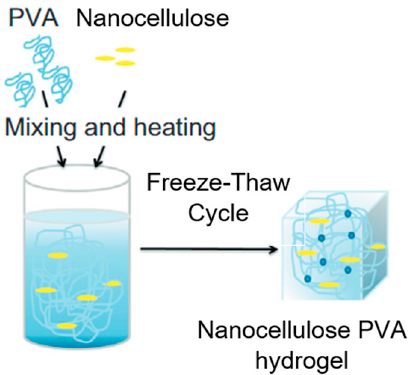
Figure 7. Simple process of nanocellulose hydrogel production (modified from [115]).